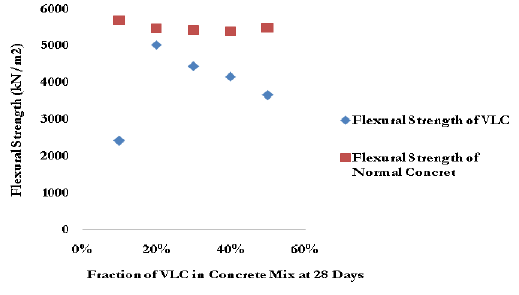
Fig.5. Flexural Beam of Volcanic Concrete (kN/m 3